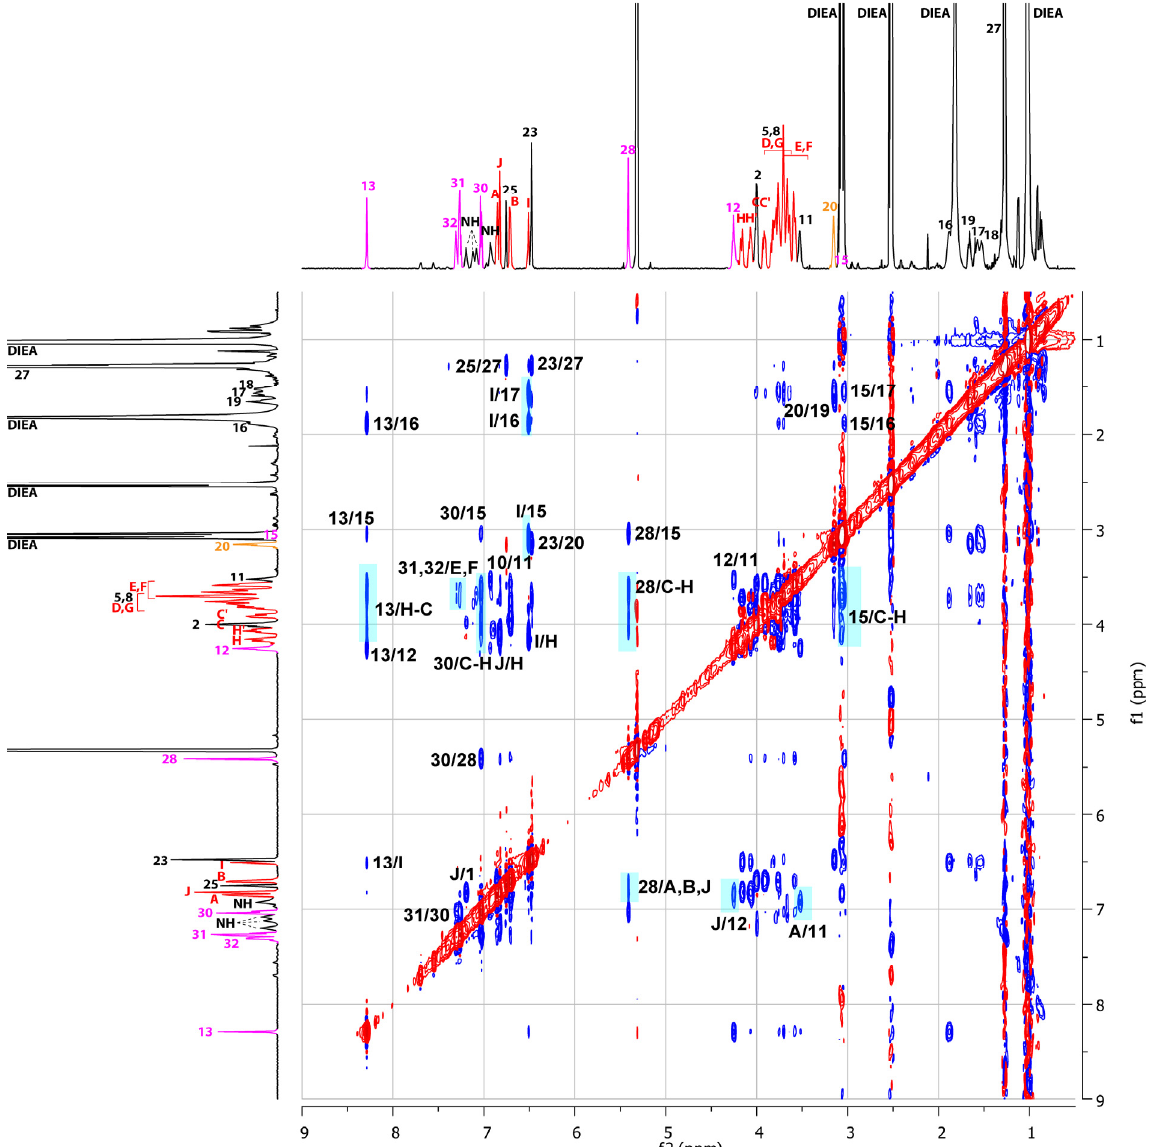
Figure 7. 1 H-NMR ROESY experiment (600 MHz, CD tightened molecular lasso 14 . The coloring, lettering and numbering correspond to the proton assignments indicated in Scheme